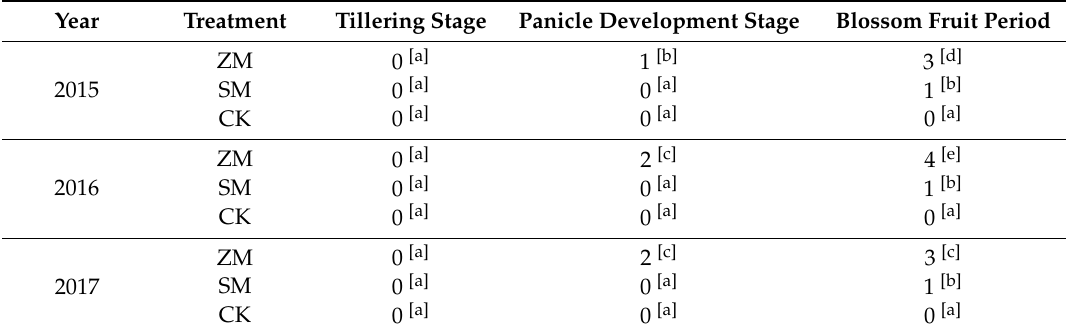
Table 3. E ff ect of di ff erent films mulching on rice